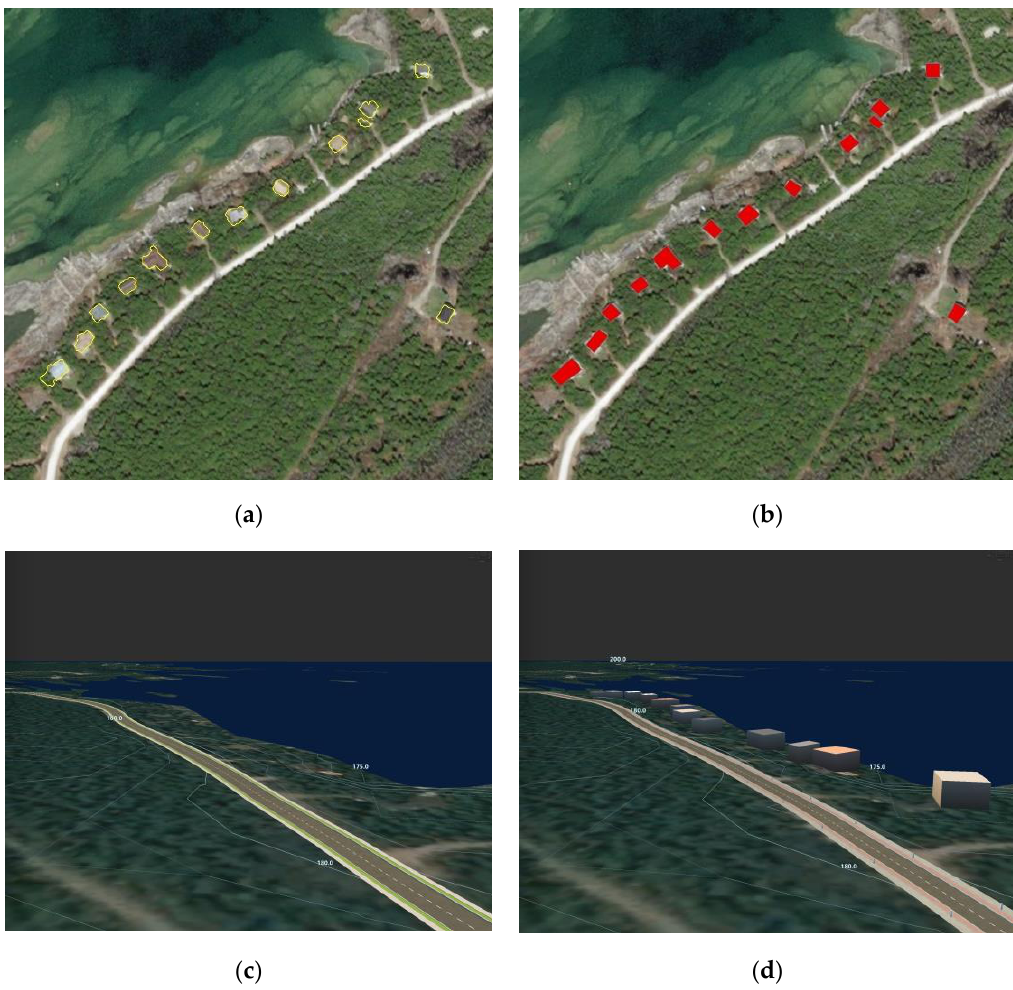
Figure 16. Simplified building models ( b ) obtained in AIF from building footprints ( a ) detected from LiDAR data classification. At the bottom: the model from OSM, where buildings are not available ( c ) and the result achieved with the proposed approach ( d ).